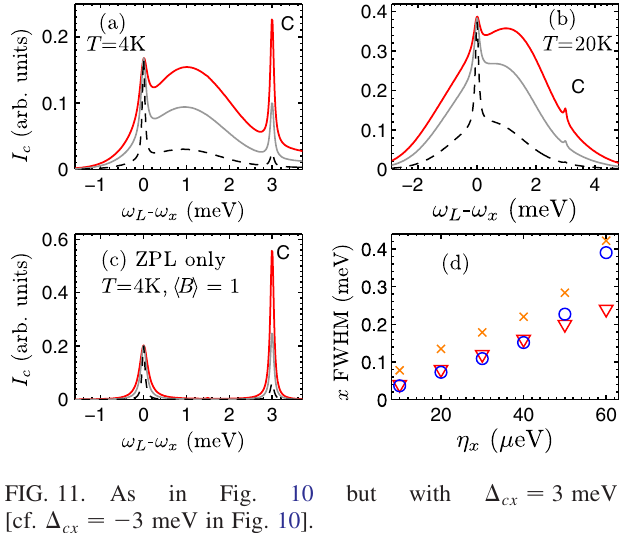
FIG. 11. As in Fig. 10 but with (cid:1)